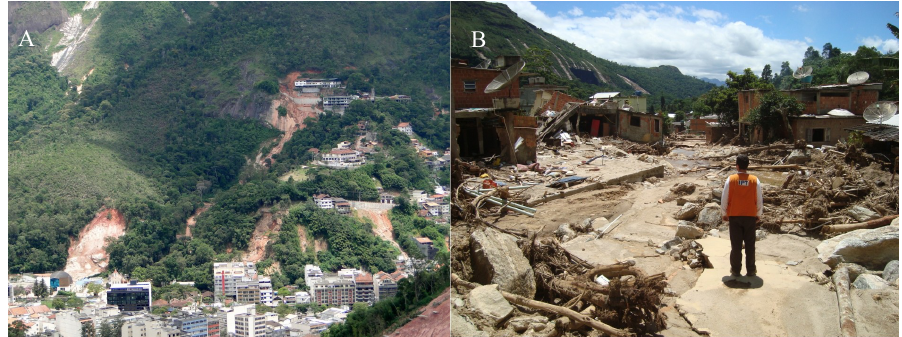
Figure 1. ( A ) Nova Friburgo 12/01/2011 ( B ) Teresópolis 12/01/2011photos: Instituto de Pesquisas Tecnológicas-IPT/RJ. Table 1. Human consequences in the 2011 disaster in Rio de Janeiro State, Brazil. Municipality